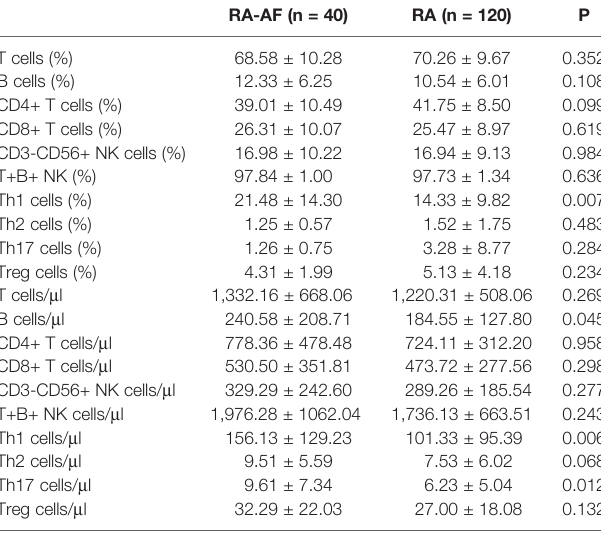
TABLE 2 | Absolute numbers and ratios (%) of peripheral lymphocyte subsets in patients with RA-AF and RA.